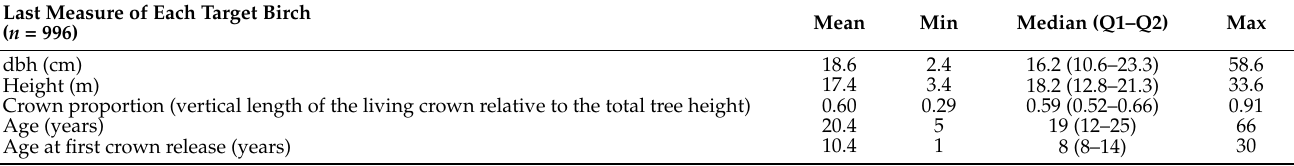
Table 2. Description of the studied crown released target birch trees at their last measurement (Only one measure per tree): Some target birch were harvested earlier than the others within their plot to prevent crown contact between target trees. They had been predesignated as extra target birch for a further designation or because of underestimation of crown